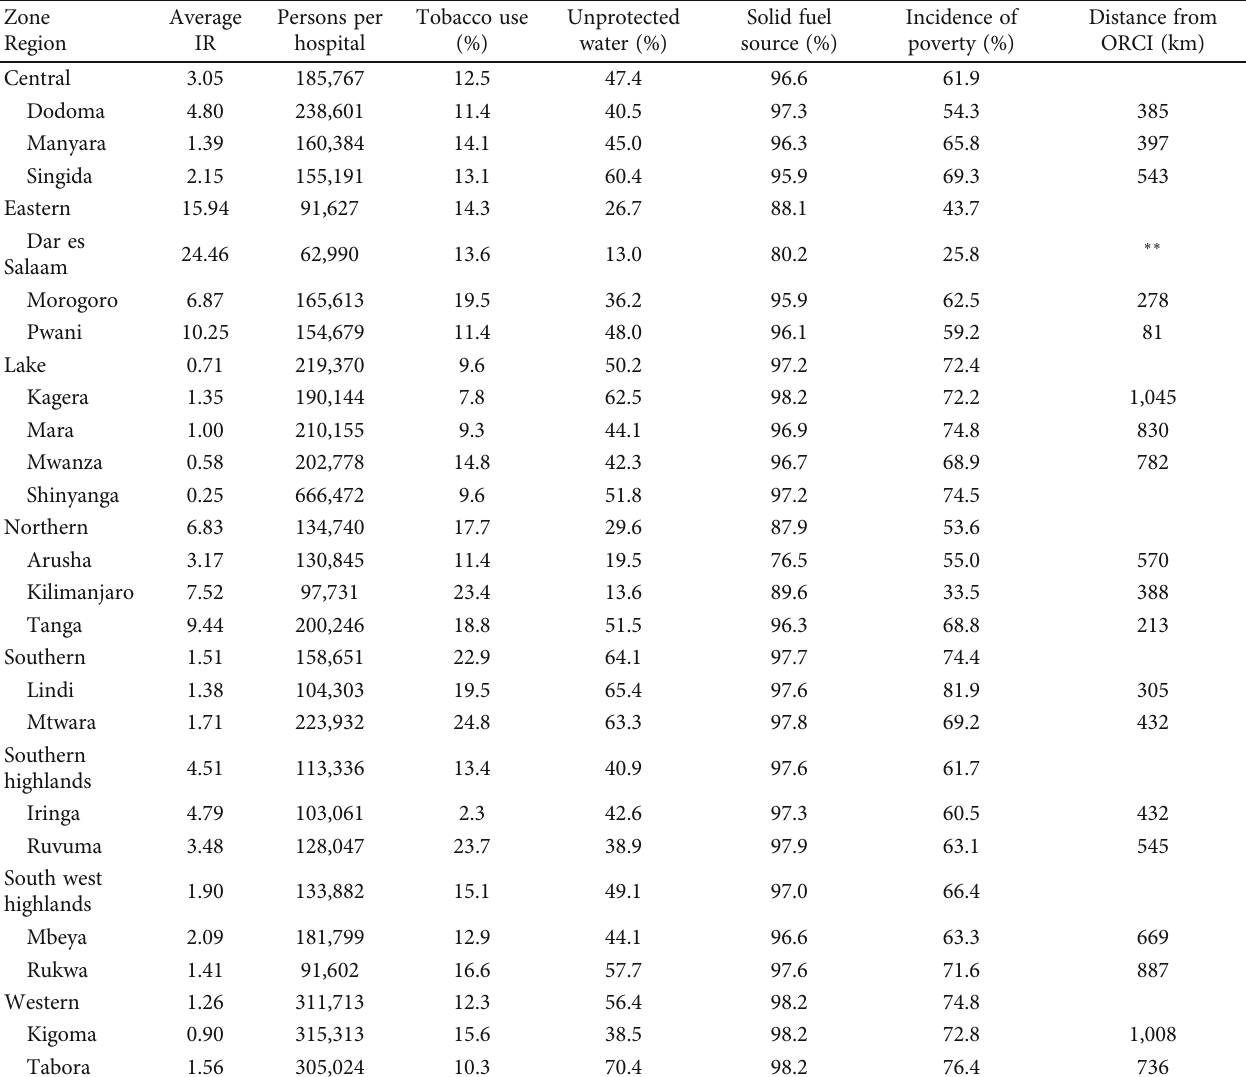
Table 3: Zonal and regional average incidence rate (IR ∗ ) from 2006-2016, access to diagnosis, and population-level risk factors. Zone